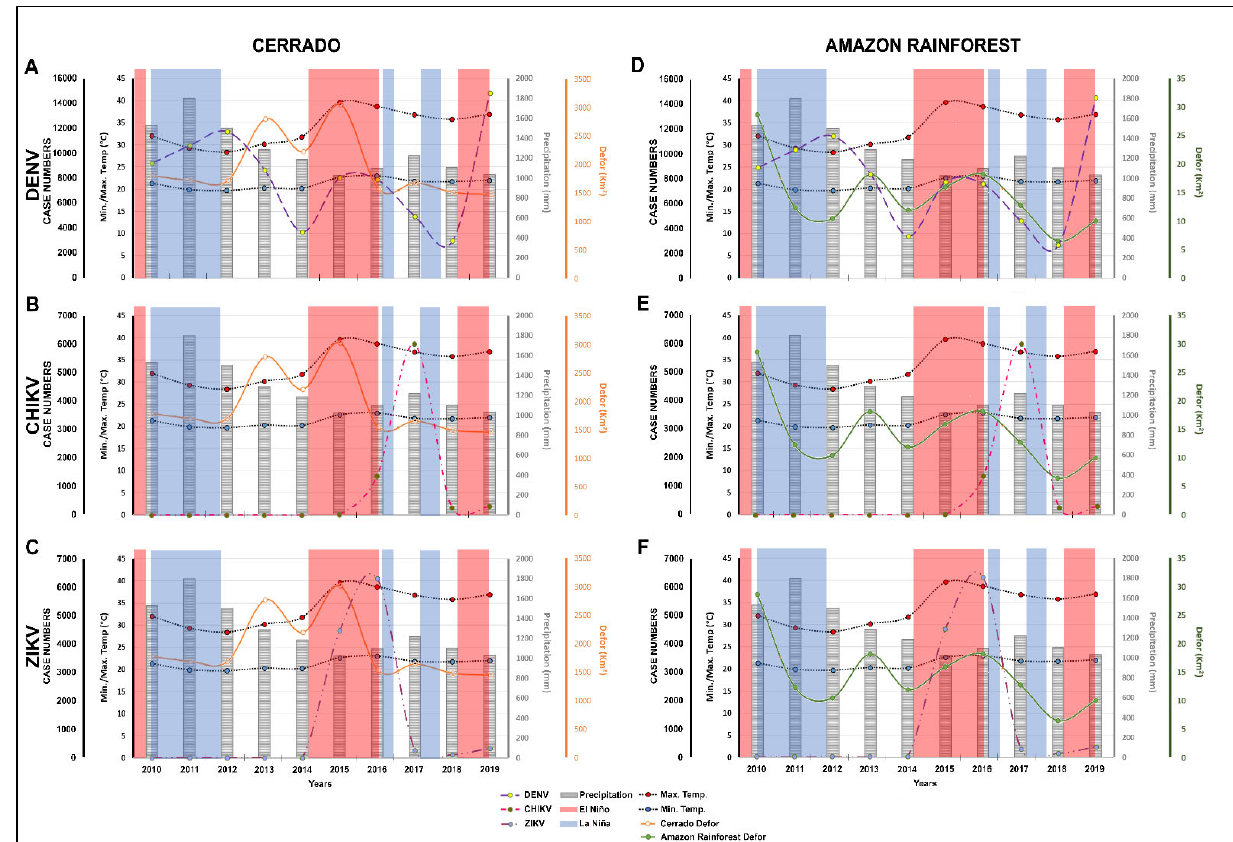
Figure 2. Distribution of the environmental modifications and of the cases of human infections by the DENV, CHIKV and ZIKV between the years 2010 and 2019 in Tocantins, Brazil. ( A – C ) Show the cases of human infections by dengue, chikungunya and Zika viruses, respectively, and their relationships with the natural phenomena (temperatures, precipitation, El Niño/La Niña) and deforestation that occurred in the Cerrado biome within Tocantins from 2010 to 2019. ( D – F ) Show the same cases of human infections by dengue, chikungunya and Zika viruses, respectively, and their relationships with changes in temperature, precipitation, El Niño/La Niña and the deforestation that occurred in the Amazon Rainforest biome within Tocantins from 2010 to 2019.